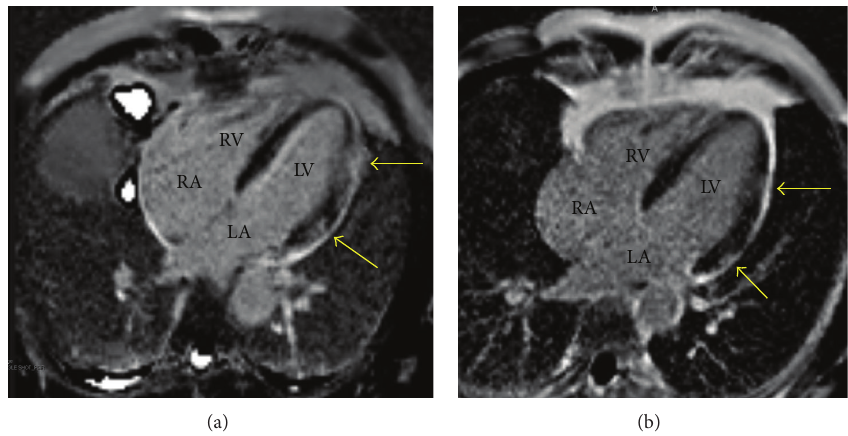
Figure 2: Cardiac magnetic resonance image (four-chamber view). (a) Presentation: patchy areas of late gadolinium enhancement (LGE) were detected transmurally in the mid lateral left ventricular (LV) wall and in the midwall with extension to the subepicardial in lateral and anterior LV walls near the base consistent with diffuse inflammation in a noncoronary distribution (arrows). (b) 6 weeks after presentation: markedly reduced LGE (arrows) consistent with improvement in inflammation without significant residual fibrosis. LV: left ventricle, RV: right ventricle, LA: left atrium, and RA: right